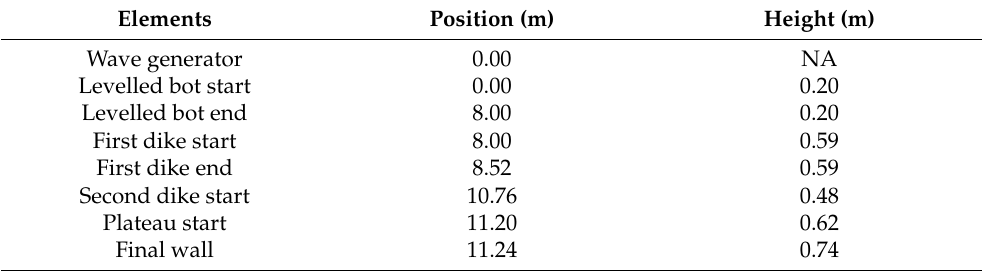
Table 3. Position of different elements of structures in the physical experiment.